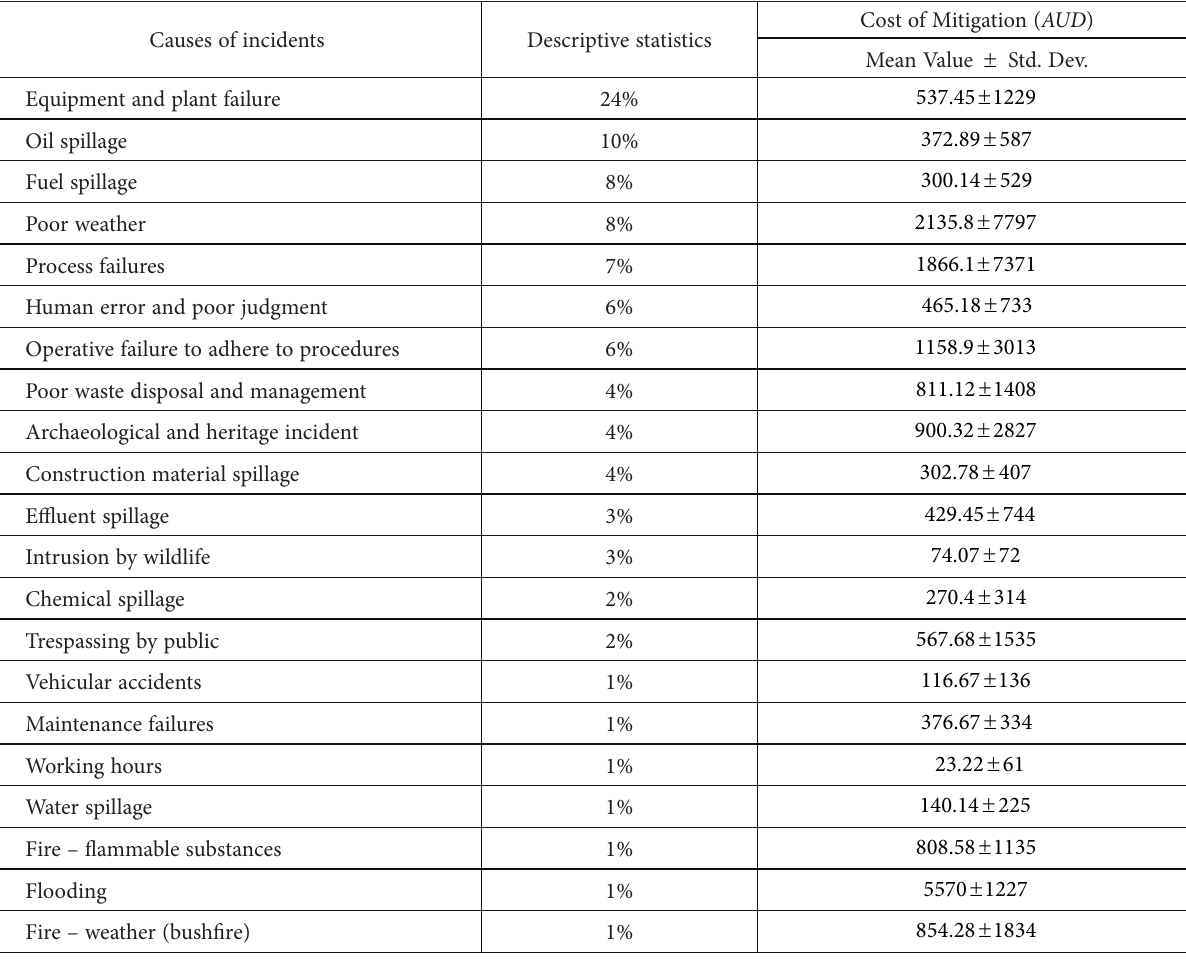
Table 2. Causes of environmental incidents